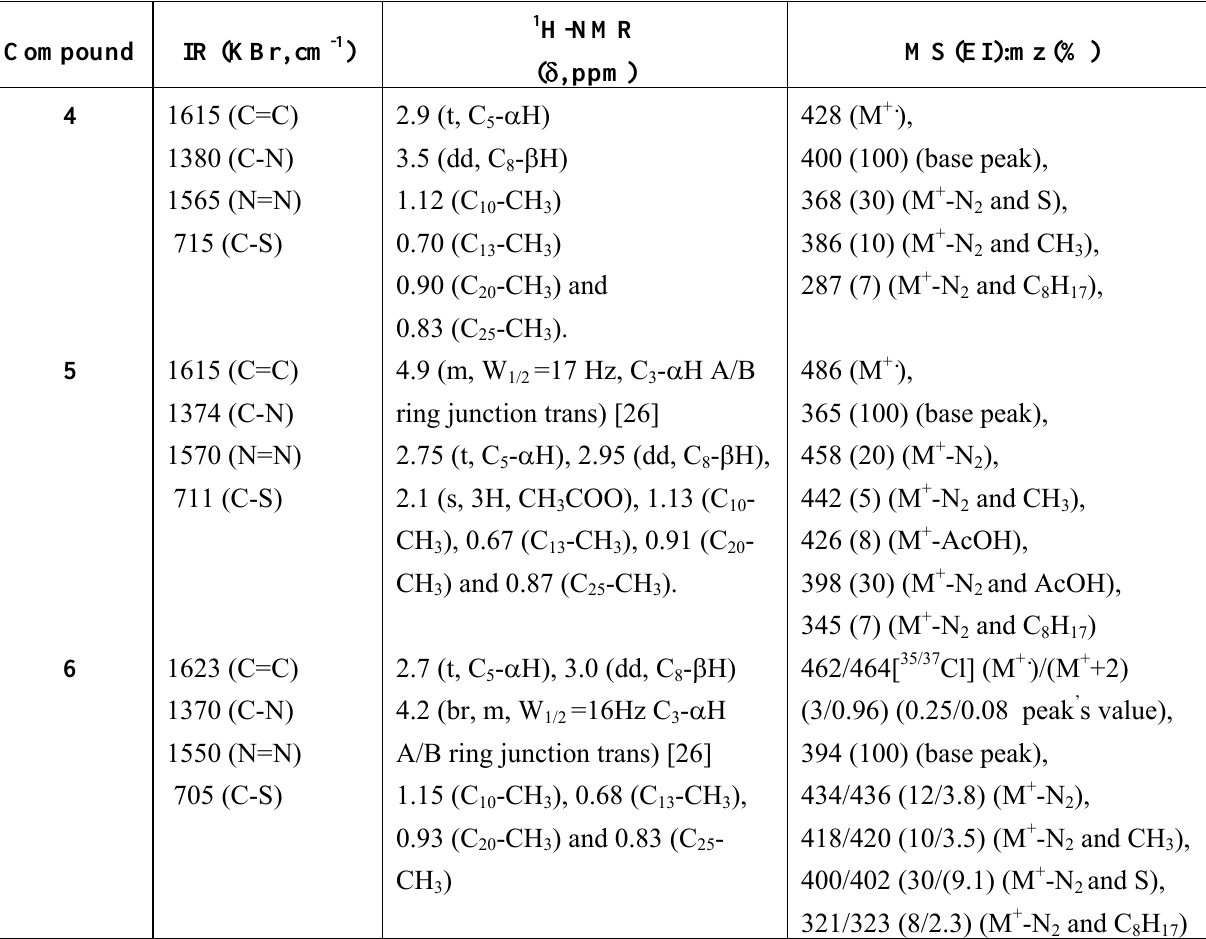
Table III Spectral data for compounds 4 -